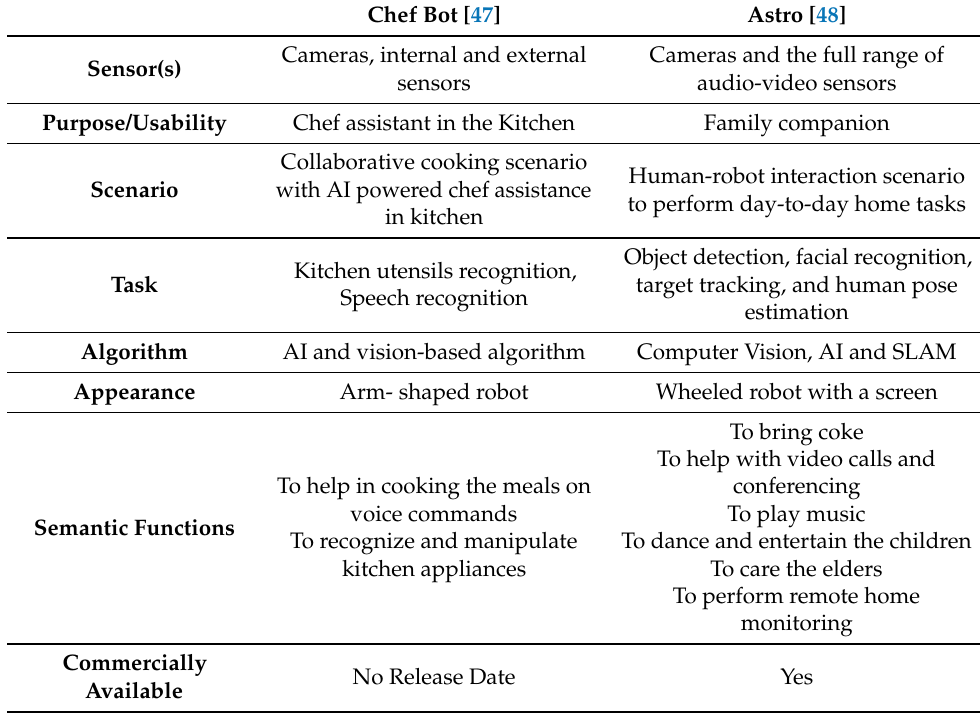
Table 4. Robots in Domestic